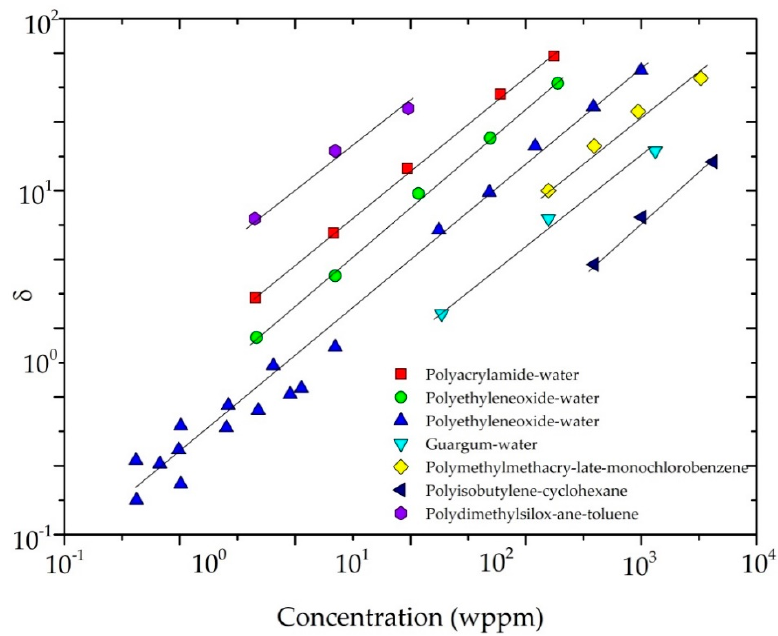
Figure 4. The concentration of polymer and solvent affects fluid slope; the slope then alters the drag reduction percentage.